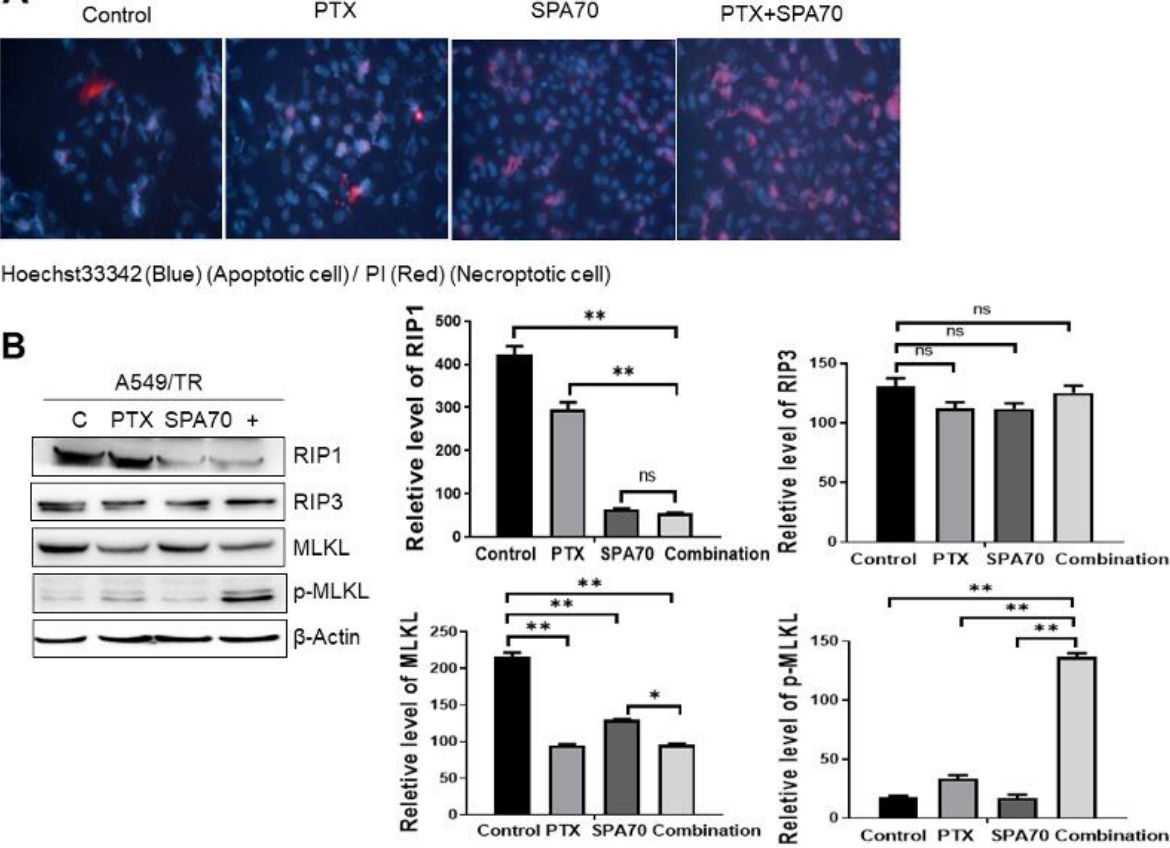
Figure 5. SPA70 and combination regimen induces necroptosis and exacerbates cell death. All the experiments were treated with 2 nM PTX, 10 µ M SPA70, or combined regimen for 48 h. ( A ) Merge pictures showing Hoechst 33342 (specifically stains apoptotic cells) and PI (specifically stains necroptotic cells) staining in all indicated groups. The photographs were taken by fluorescence mi- croscopy (200×). ( B ) Western blot analysis of classic RIP1-RIP3-MLKL pathway in all treatment groups ( n = 3). “+” indicates combination treatment of PTX and SPA70. *, p < 0.05; **, p < 0.01, com- pared with indicated groups. Ns means no statistical significance.